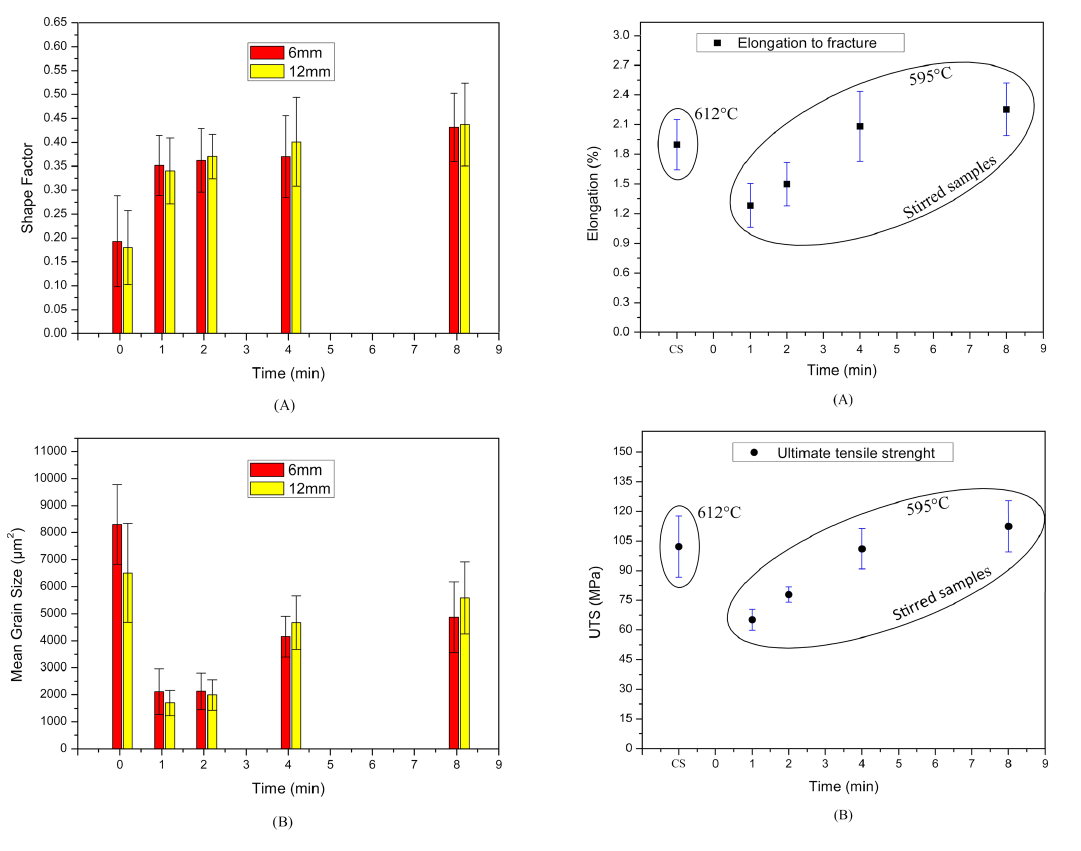
Figure 7. Results of the shape factor (A) and mean grain size (B) of the primary α - Mg phase in the samples processed at the different diameters and stirring times.